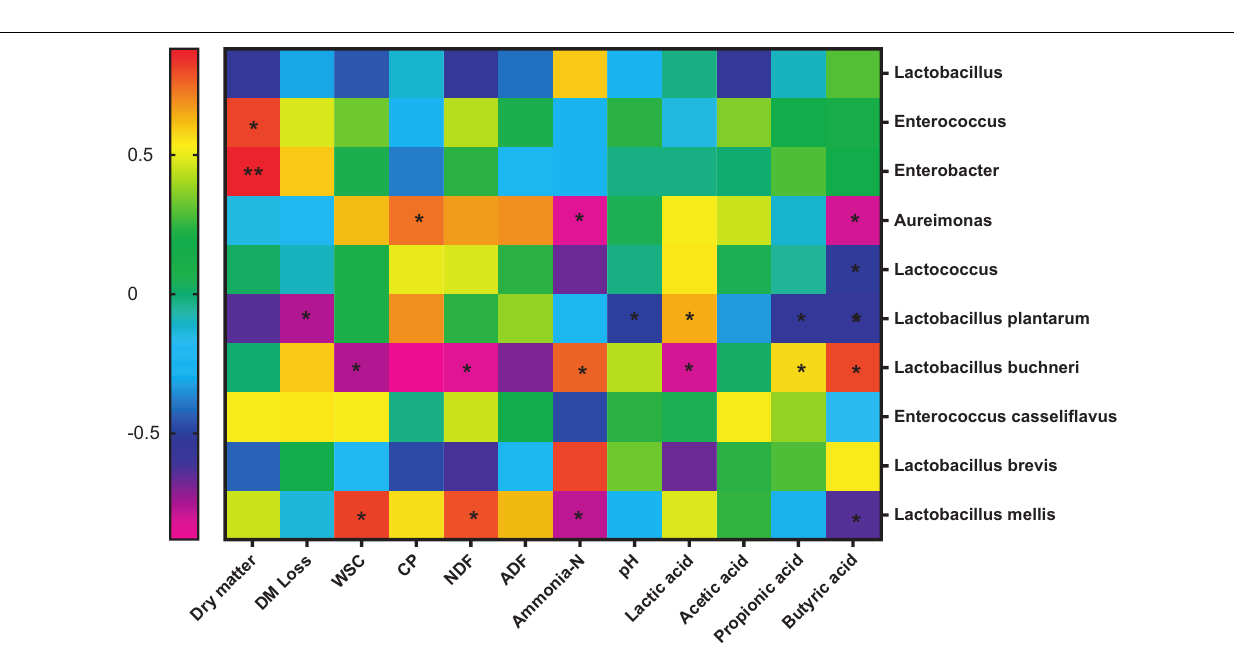
Frontiers in Microbiology |